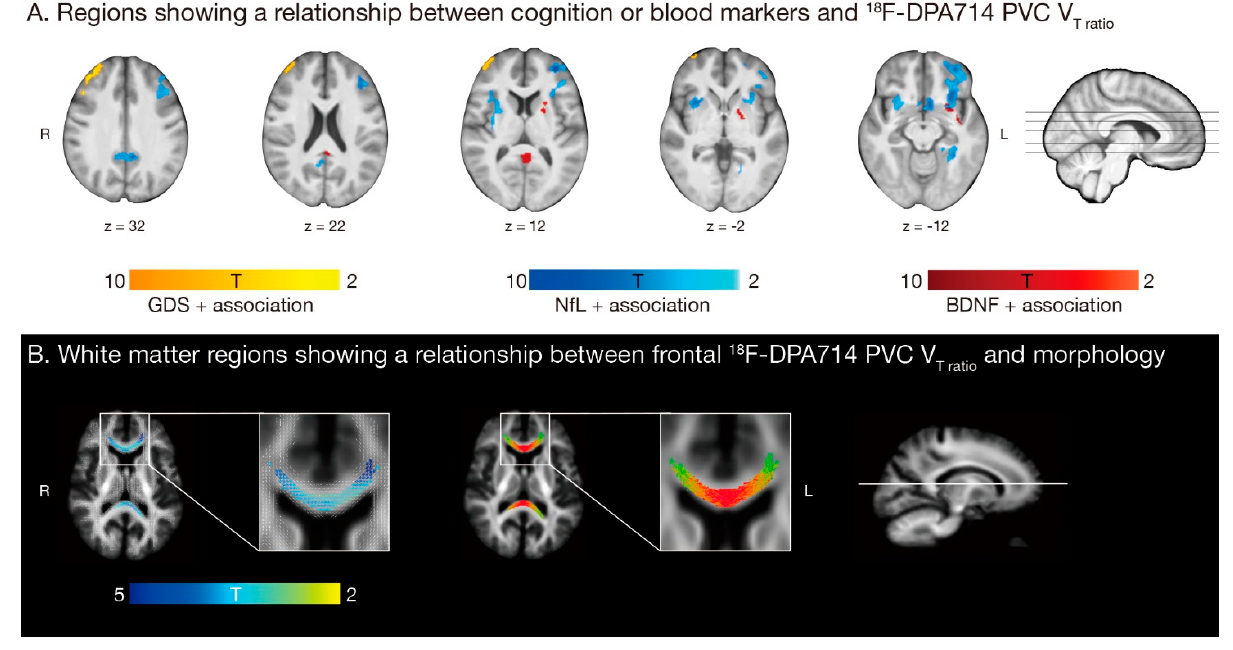
Figure 4. The relationship between neuroinflammation and clinical parameters and white matter microstructure in 15 chemotherapy treated (C+) breast cancer patients. ( A ) Global deficit score (GDS, orange; corrected for yes/no higher education), neurofilament light chain (NfL, blue; corrected for age) and brain-derived neurotrophic factor (BDNF, red; corrected for age) showed a significant positive association with partial-volume corrected (PVC) total distribution volume (V T ) -ratio in the temporal lobe, putamen, and caudate, and additionally in the frontal pole and insular cortex for NfL and parietal lobe for BDNF. ( B ) Fixels with a significant negative association with frontal V T-ratio are shown on the left (blue-green, white = all fixels; corrected for age and intracranial volume). The right image shows streamlines passing through fixels showing a significant negative association (colored by direction; red: left-right, green: anterior-posterior, blue: inferior-superior), in the forceps major and minor of the corpus callosum. All models are with threshold p uncorrected < 0.001, p FWE-corrected < 0.05.